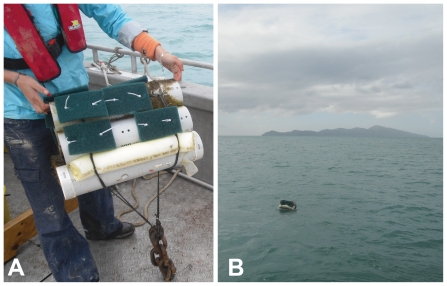
Experimental setup.(a) Artificial Island (AI) ready for deployment (b) Deployed AI near Kapiti Island.